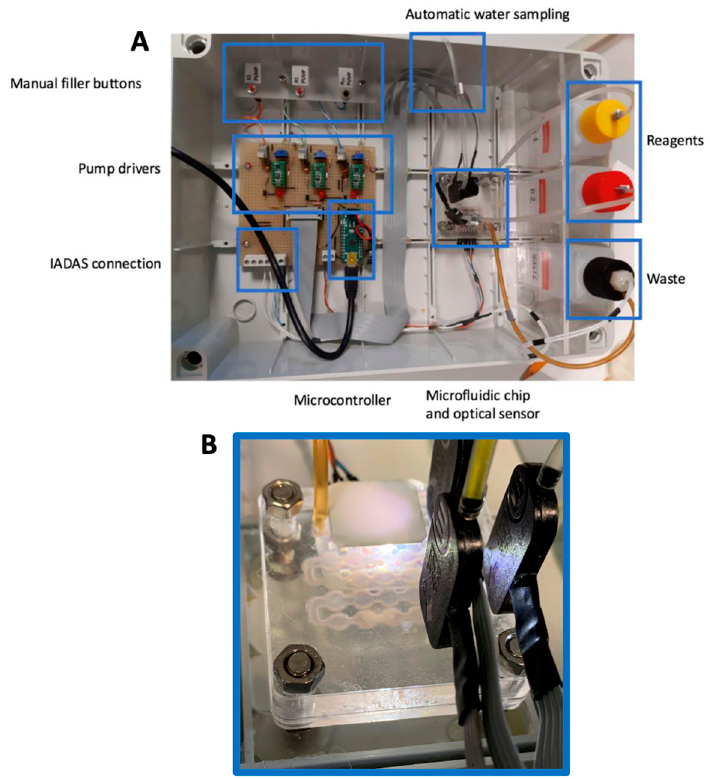
Figure 4. ( A ): top view of the sensor platform with evidenced subsystems. ( B ): Close view of the lab-on-a-chip connected to pumps and optoelectronics components.